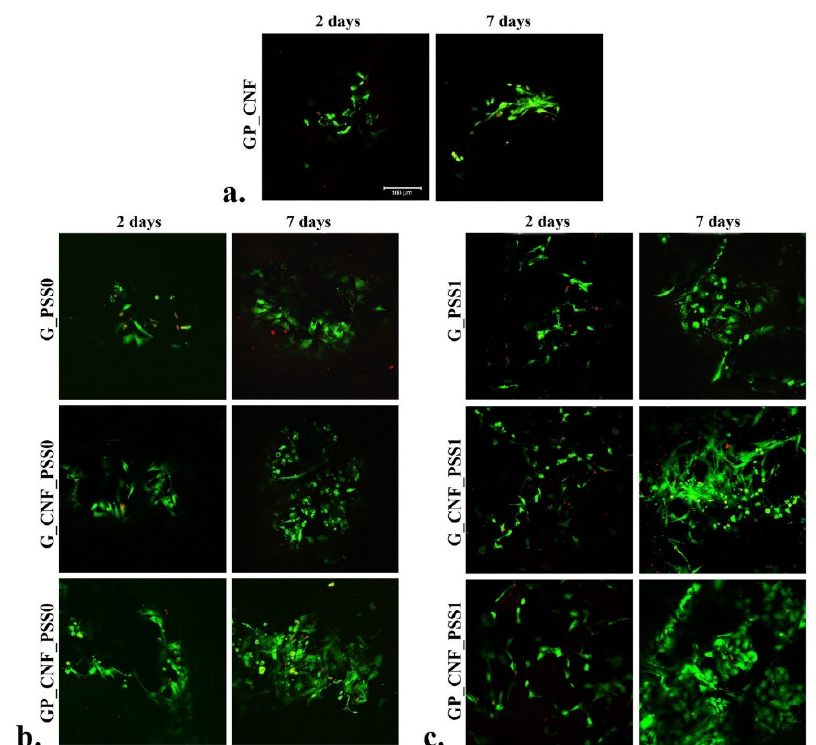
Figure 5. Qualitative evaluation of cell viability and proliferation during seven days of culture under standard conditions observed by Live/Dead fluorescent staining coupled with confocal microscopy in ( a ), GP_CNF scaffold, ( b ) PSS0-enriched scaffolds and ( c ) PSS1-enriched scaffolds. The nuclei of viable cells are green, while the nuclei of dead cells are red. Scale bar 100 μm.